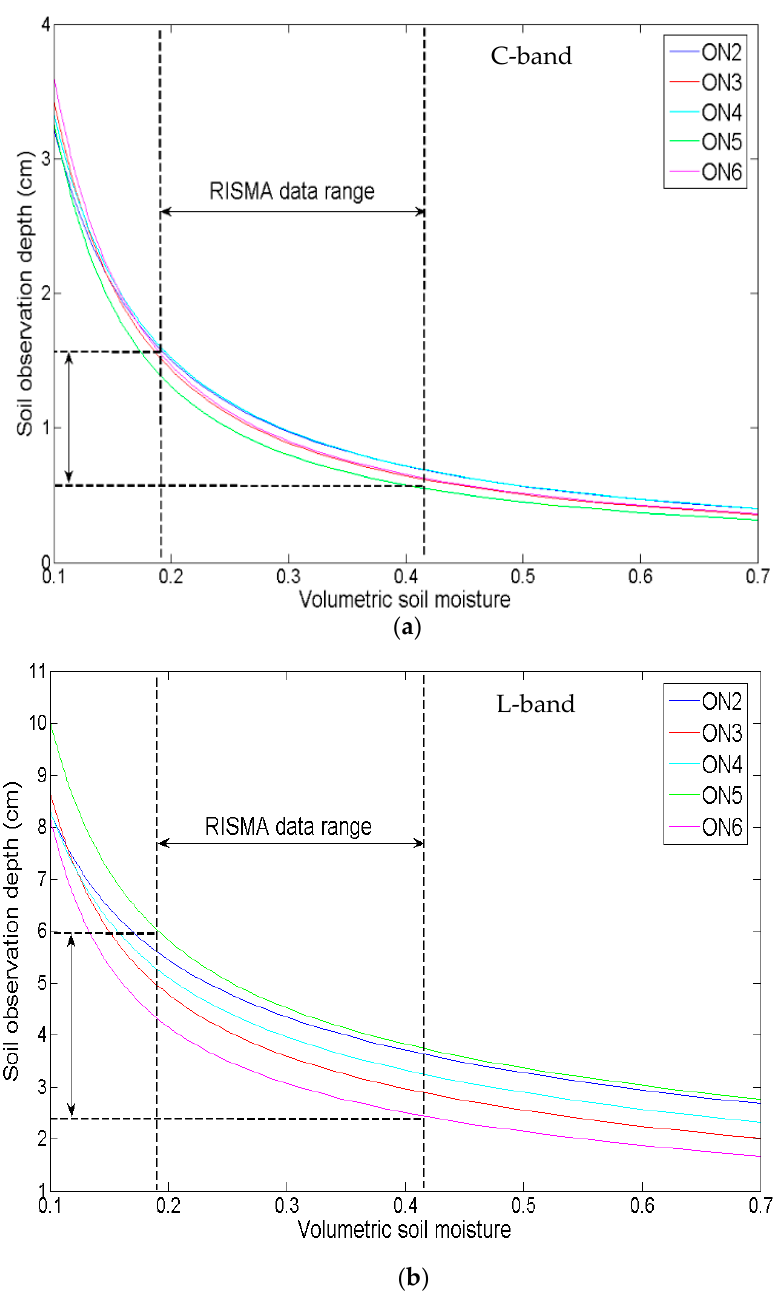
Figure 12. Simulated soil observation depths with C-band ( a ) and L-band ( b ) based on soil texture of five RISMA station’s fields.